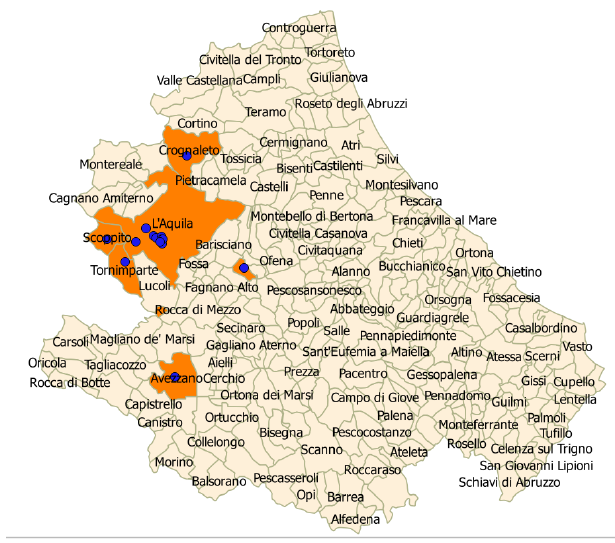
Figure 15. The census of damaged municipalities (within the first hour).